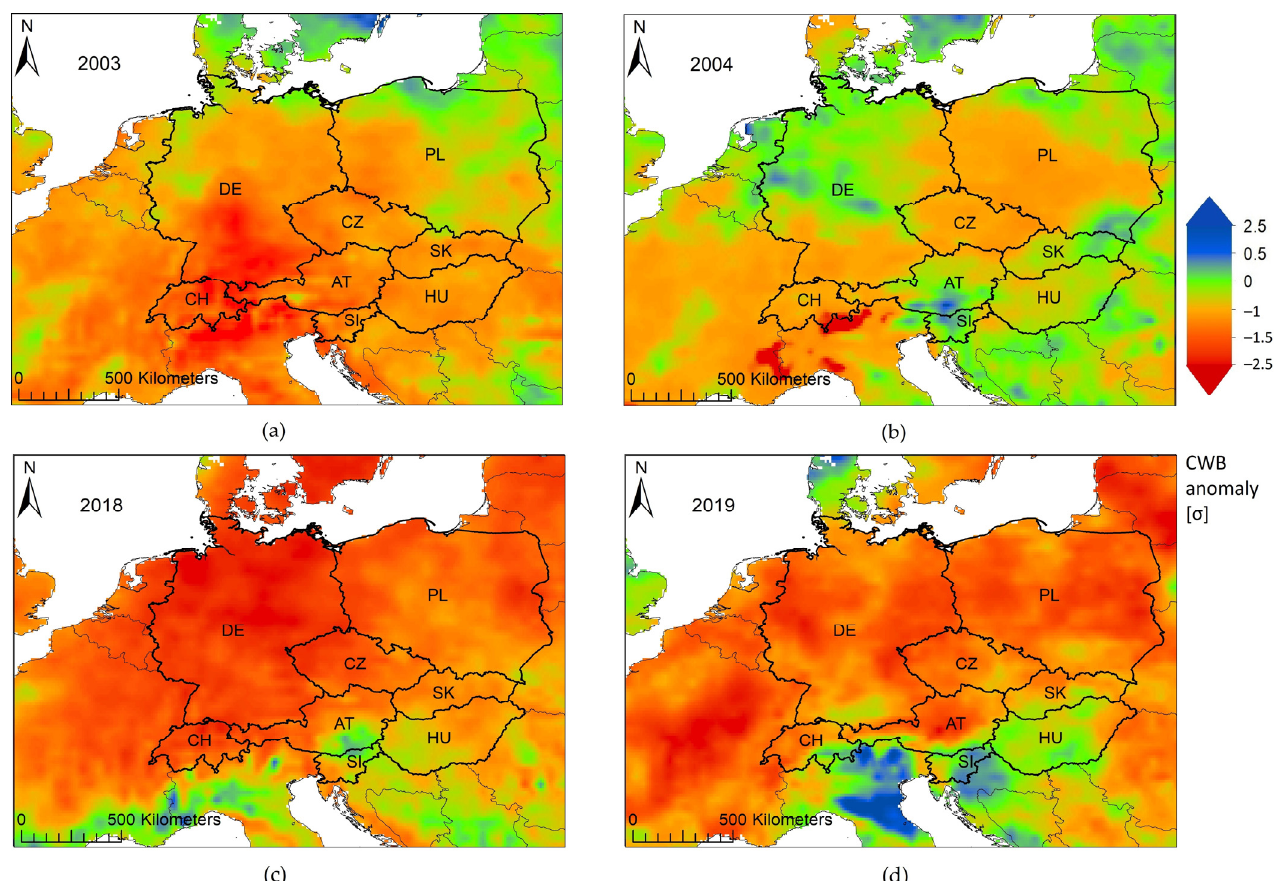
Figure 3. Standardized anomaly of the climatic water balance (CWB, mm) given as sigma ( σ ) for the years 2003 ( a ), 2004 ( b ), 2018 ( c ), and 2019 ( d ) as the deviation from the summated mean of the vegetation period (April–September) from the reference time of 1991–2020. CWB was calculated as the difference between monthly precipitation [28] and monthly potential evapotranspiration (PET, mm). PET was calculated separately [37,38], utilizing the latitude and monthly mean temperature [28] in the SPEI package [39] of the R software [40]. Each assessed grid point is 0.1 × 0.1 degree, roughly 9 × 9 km. AT: Austria; CH: Switzerland; CZ: Czechia; DE: Germany; HU: Hungary; SI: Slovenia; SK: Slovakia; PL: Poland. Shapefiles of countries downloaded from Eurostat [41]. The downloaded ERA-5 Land climate data for temperature and precipitation [28] existed in NCDF format, was read into R software using the package “ncdf4” [42]. Raster package [43] was used to convert this NCDF data into raster format. See Text S1 for detailed methods description. © Thünen Institute, 2022.